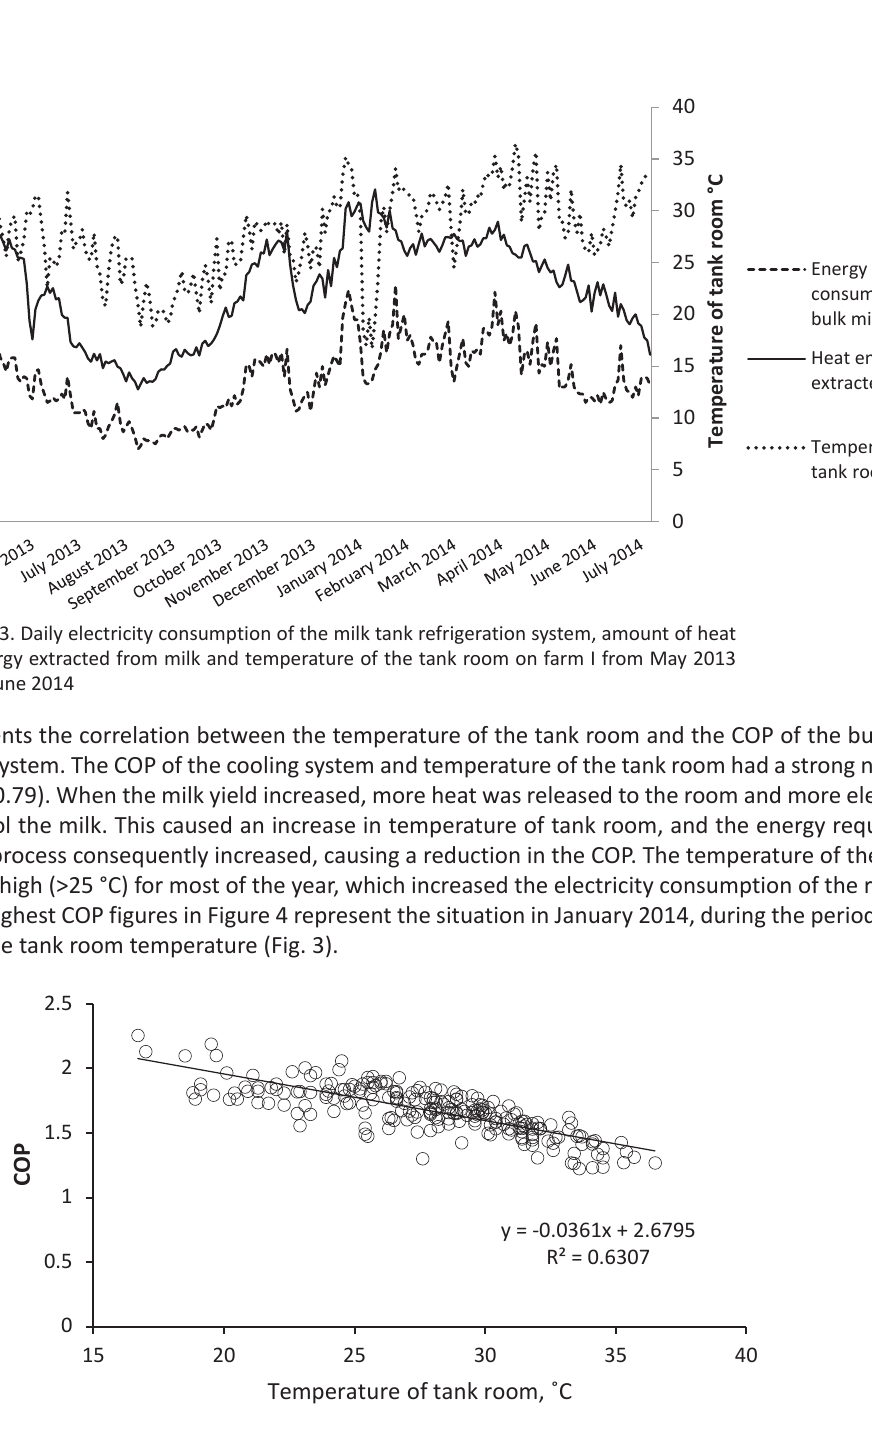
Fig. 4. COP of the refrigeration system with respect to the temperature of the tank room on farm I, and the linear regression model for the